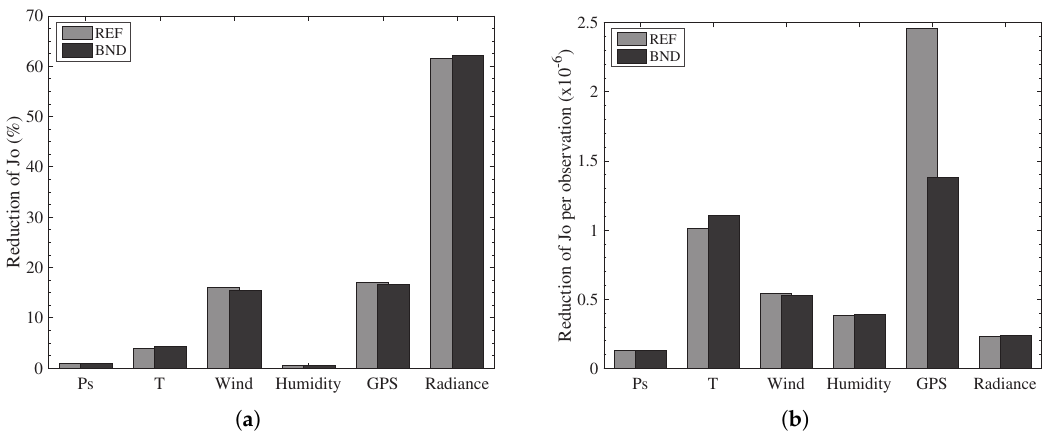
Figure 4. Contribution of ( a ) each type of observation (in %) and ( b ) each type of observation normalized by the number of observations used in each case, in the reduction of the total cost function in the analysis generated for 10 August 2014 at 1200 UTC.